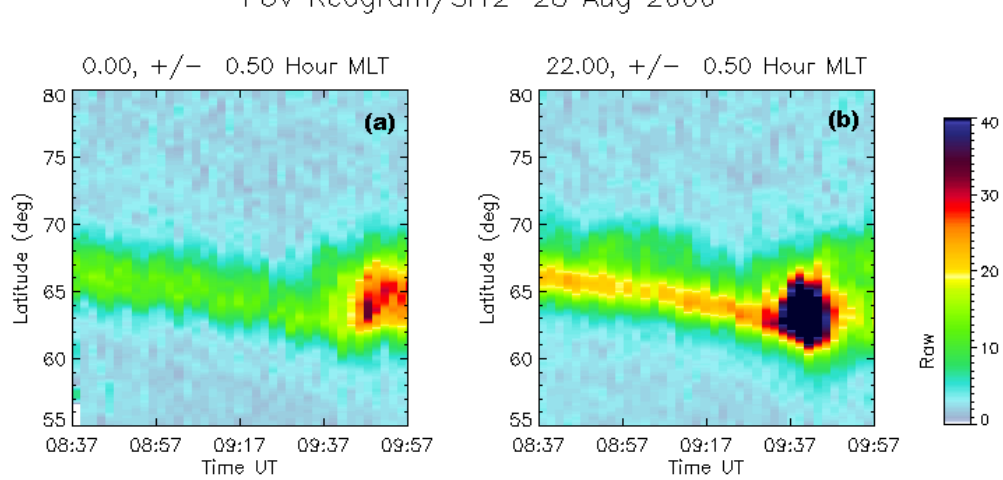
Fig. 6. Example of a growth phase observed on 28 August 2000 event. Panel (a) is a keogram of the proton precipitation observed with SI12 in the midnight sector (between 23:30 and 00:30 MLT). Panel (b) is the keogram in the onset sector (between 21:30 and 22:30 MLT in this case).